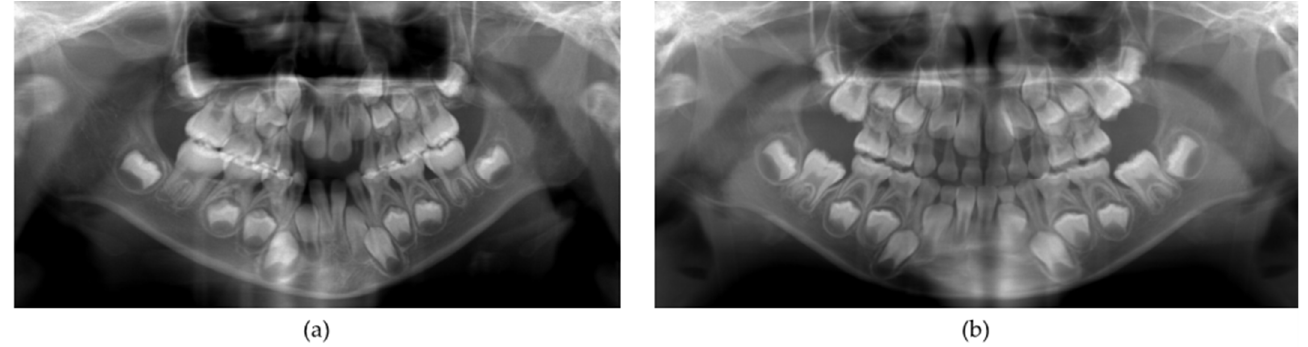
Figure 1. Exfoliated mandibular primary central incisors: ( a ) Older sister (seven years and three months); ( b ) Younger sister (six years and one month).